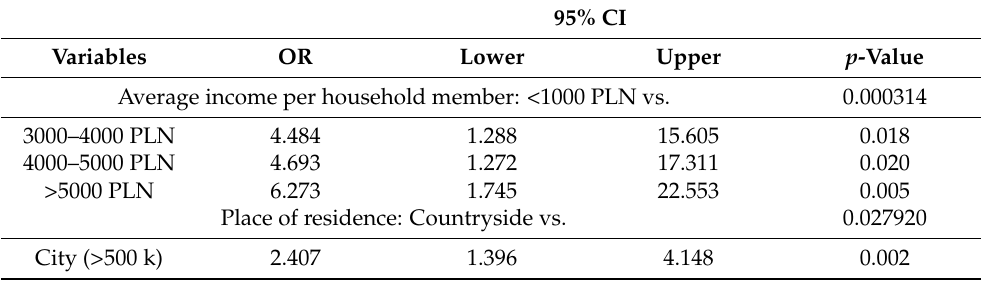
Table 10. Multivariate analysis regarding COVID-19 vaccination status.